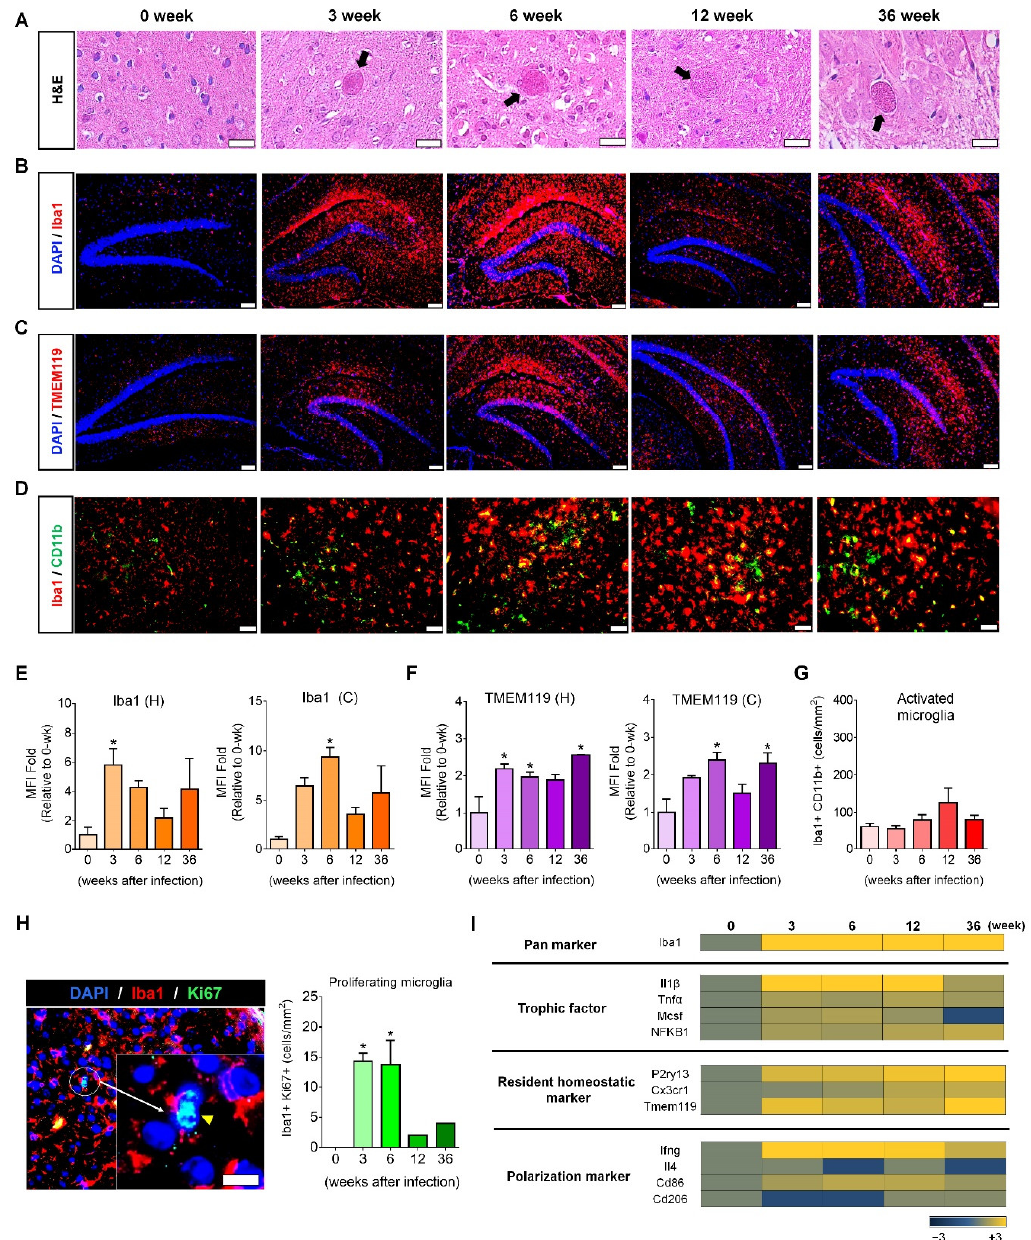
Figure 1. Proliferation and activation of resident homeostatic microglia over 36 weeks after Toxoplasma gondii infection. ( A ) T. gondii infection was confirmed by the presence of cysts in brain tissue (H&E staining; scale bar, 20 µm). ( B ) Microglia in the hippocampal formation were stained with Iba1 (red; scale bar, 100 µm). ( C ) Microglia in the hippocampal formation were stained with TMEM119 (red; scale bar, 100 µm). ( D ) Activated microglia were co-stained with CD11b and Iba1 (green and red, respectively; scale bar, 50 µm). ( E , F ) Mean fluorescence intensity (MFI) was calculated from fluorescence-stained images ( B , C ) using ImageJ. The fold changes of MFI at 3, 6, 12, and 36 weeks PI were compared with those of the control (0 weeks). H, hippocampus; C, cortex. ( G ) The number of activated microglia (Iba1 + /CD11b + ) was designated by cell num- ber per mm 2 of the brain tissue. ( H ) Ki67-stained proliferating microglia. The yellow arrow head shows microglial cells in the mitotic phase (sky blue) co-stained with DAPI (blue) and Ki67 (green), and the number of proliferating microglia (Iba1 + /Ki67 + ) was designated by cell number/mm 2 brain tissue. Scale bar; 20 µm. Quantification of MFI intensity and co- stained cell counting; two brain sections per mouse. ( I ) Microarray analysis of genes encoding trophic factors, homeostatic markers, and M1 and M2 markers in T. gondii -infected brain. Data are represented as the mean ± SEM. * Statistical signif- icance compared with the control (* p < 0.05).